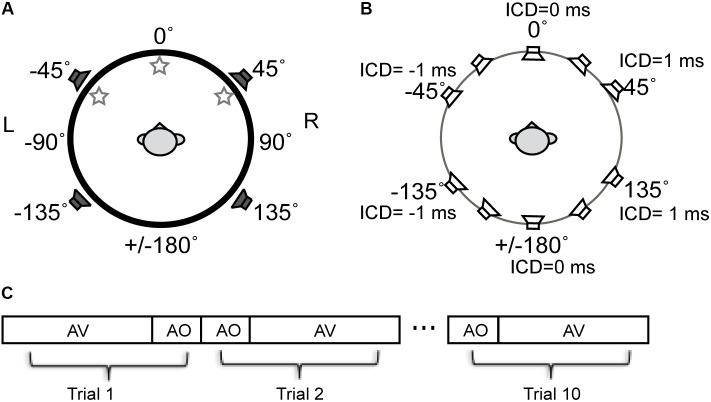
Schematic diagram of the experimental setup for stereophonic and visual stimuli used in experiments. (A) The spatial arrangement of auditory and visual cue sources described in the ±180° circular range. The negative and positive angles correspond to the left and right fields, respectively. Three LED lights were positioned at –45° (left-front), 0° (center-front), and 45° (right-front) at the subject’s eye level. Four loudspeakers were positioned at ±45° in front and ±135 in rear fields. (B) Time-delay-based stereophony configuration. The inter-channel delay (ICD) difference between left and right speakers was altered to shift the perceived azimuth of the phantom sound source. The perceived direction moves toward the leading speaker. For example, negative ICD moves the perceived sound location to the left side of the subject and positive moves the perceived sound location to the right side of the subject in both front and rear space. (C) Blocks of AO and AV stimuli were presented to a subject in random order. A total of 10 repeat was presented for each block.